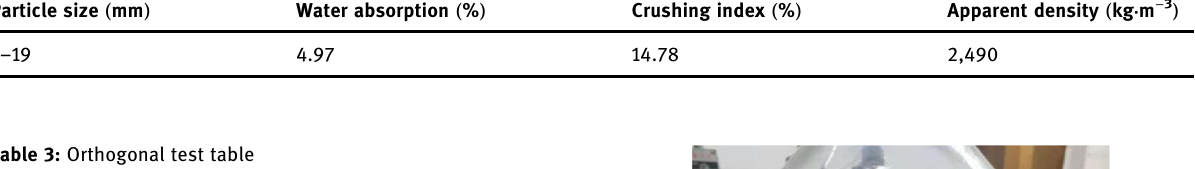
Table 3: Orthogonal test table